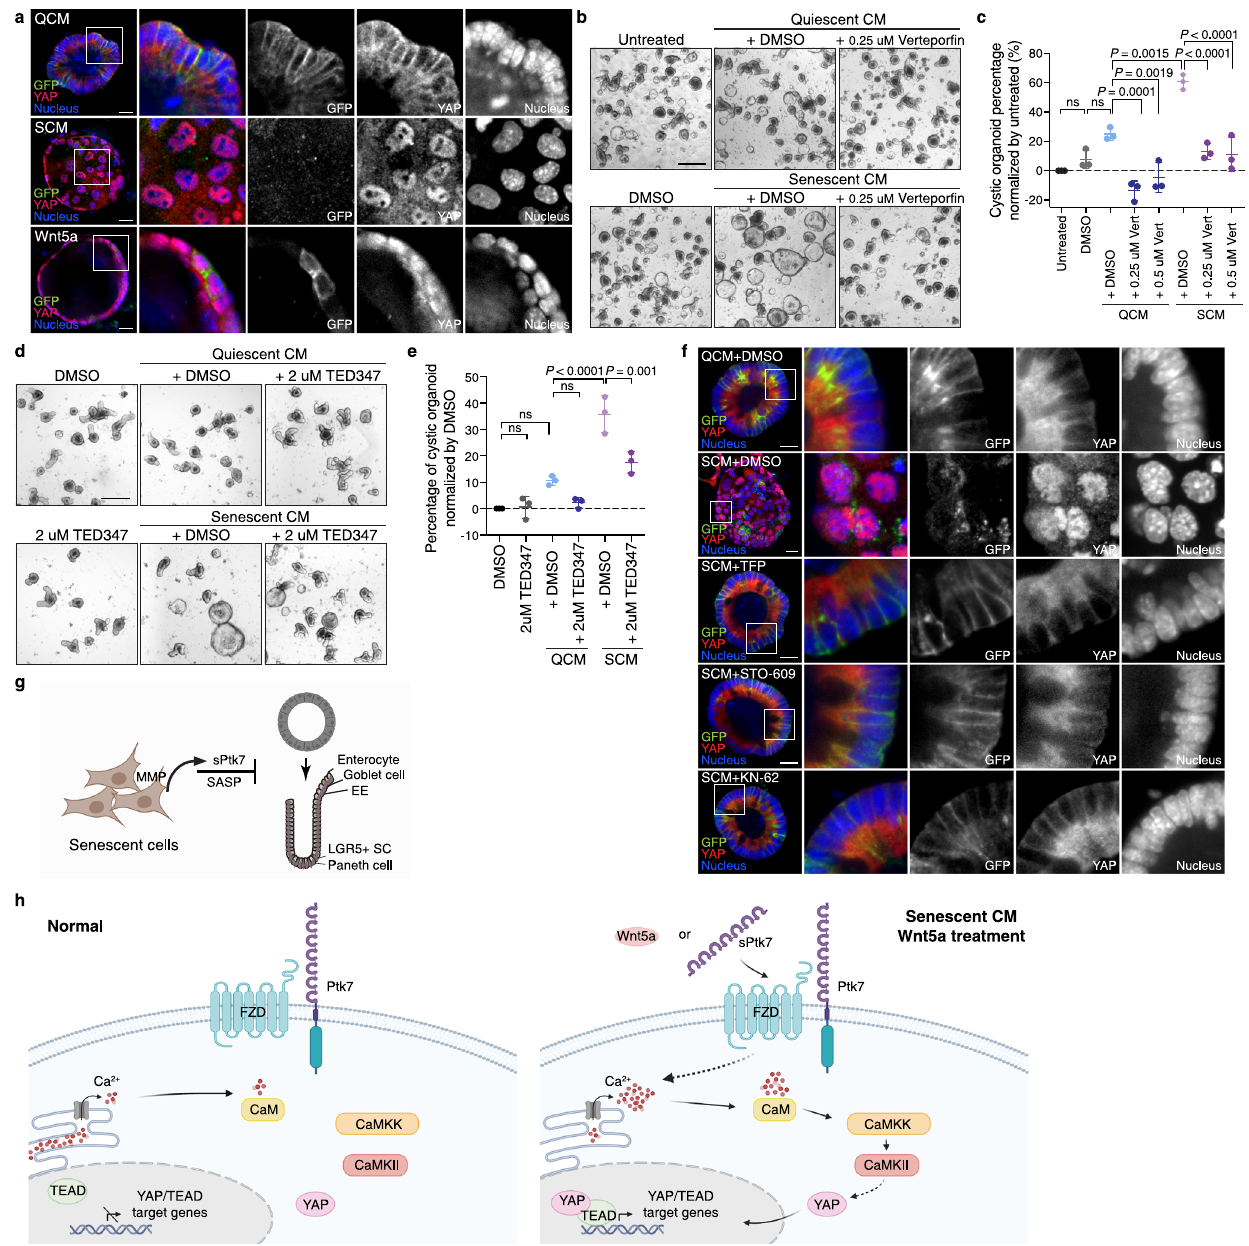
Fig. 7 | Correlation between nuclear YAP localization and cystic organoid morphology and connection to Ca 2+ signaling. a Whole mount immunostaining oforganoidsforYAP.OrganoidsestablishedfromLgr5-DTR-GFPmicewerestained for GFP, YAP, and nucleus in green, red, and blue respectively. Representative images of an organoid from each condition are shown. n =8 per each condition. Enlarged images of boxed area are shown at the right. Scale bar: 20 μ m. b Representative images of organoids cultured in QCM or SCM with DMSO or vertepor fi n.Scalebar:200 μ m. c Quanti fi cationofdatafrom( b ).Thepercentageof cysticorganoidsinorganoidsculturedinconditionedmediaispresentedasmeans ±s.d. d RepresentativeimagesoforganoidsculturedinQCMorSCMwithDMSOor TEAD inhibitors. Scale bar: 200 μ m. e Quanti fi cation of data from ( d ). The per- centage of cystic organoids in organoids cultured in conditioned media is pre- sented as means ± s.d. In ( c ) and ( e ), each dot represents a result from organoids established from a mouse, n =3. One-way ANOVA followed by Tukey ’ s post-hoc